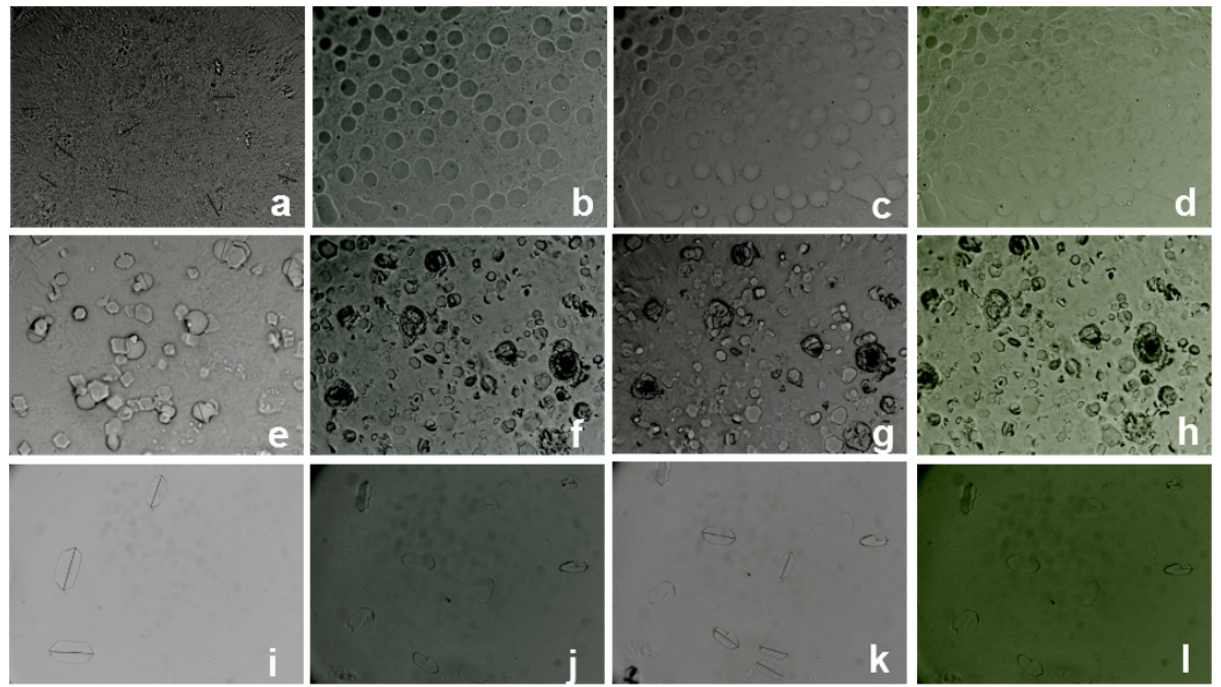
Figure 4. Optical images of: Lmp without Fluorescein ( a ) and Lmp with Fluorescein Blue filter ( b ), Bright field ( c ), and Green filter ( d ) (40×); Lmp/Dexa without Fluorescein ( e ) and Lmp/Dexa with Fluorescein Blue filter ( f ), Bright field ( g ), and Green filter ( h ) (40×); Free Dexa crystals recovered from the supernatant resulting from Lmp/Dexa without Fluorescein ( i ) and Lmp/Dexa with Fluorescein preparation Blue filter ( j ), Bright field ( k ), and Green filter ( l ) (40×).